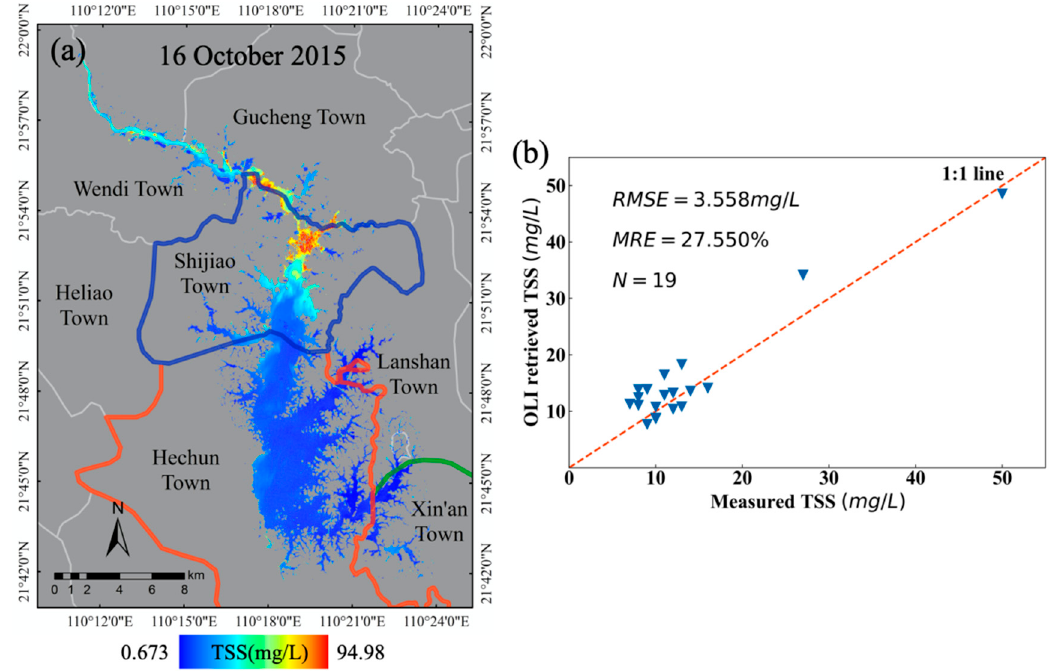
Figure 3. Estimated TSS concentrations based on the three-band model from Landsat OLI imagery in Hedi Reservoir on 16 October 2015, where the different color lines stand for towns over the reservoir basin ( a ), and comparison between the in situ measured and OLI imagery-retrieved TSS concentrations ( b ). The color scale is the legend of the TSS concentrations, in mg/L.